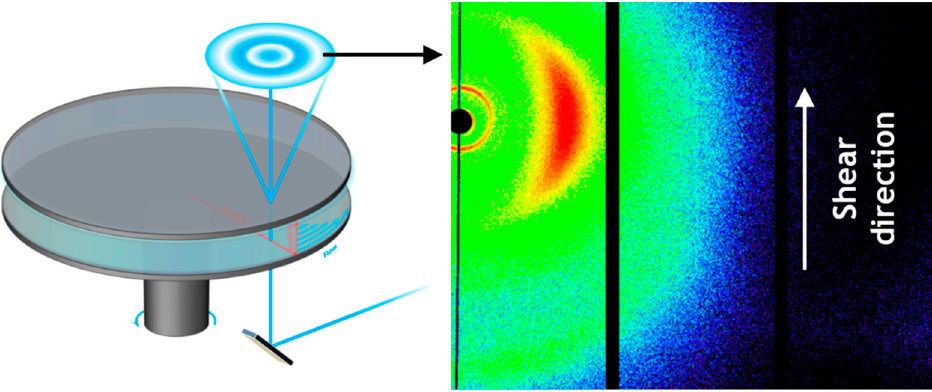
Figure 1. Schematic representation of the vertical beam path and the coordinate system of the plate-plate sensor at beamline P10 ( left ) and the characteristic wide angle X-ray diffraction (WAXD) pattern from the liquid crystalline polymer (LCP) scattering signal observed during continuous shear at a rate of 10 s − 1 ( right ).